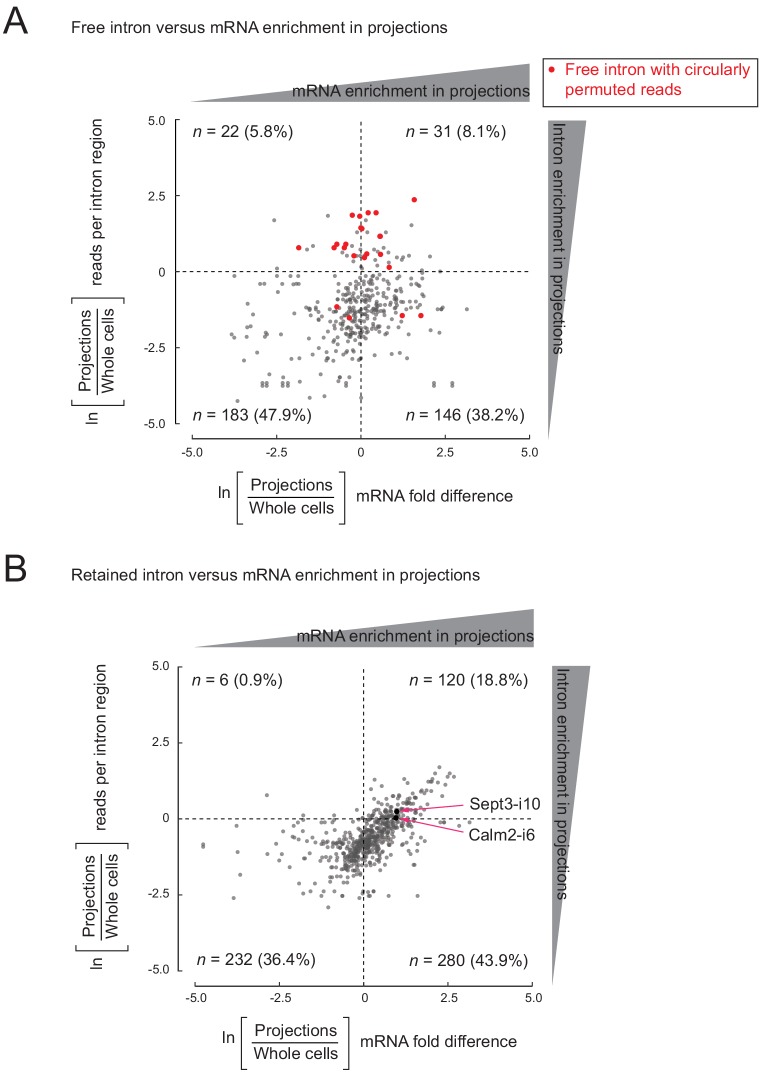
Comparison of intron enrichment versus mRNA enrichment in projections.